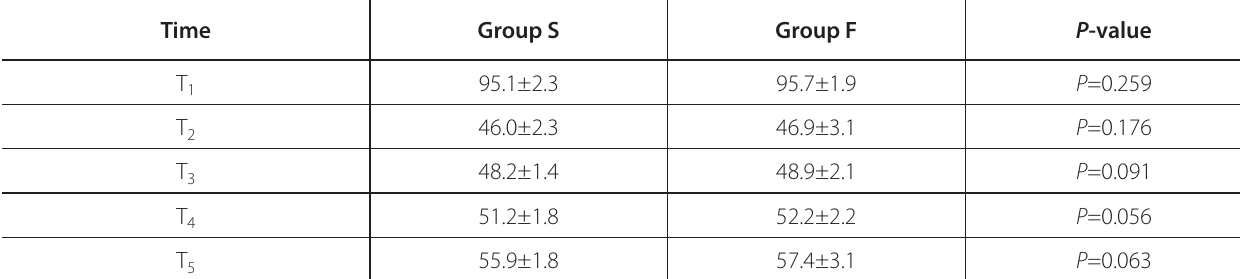
Table 2 . Comparison of the BIS value at each time